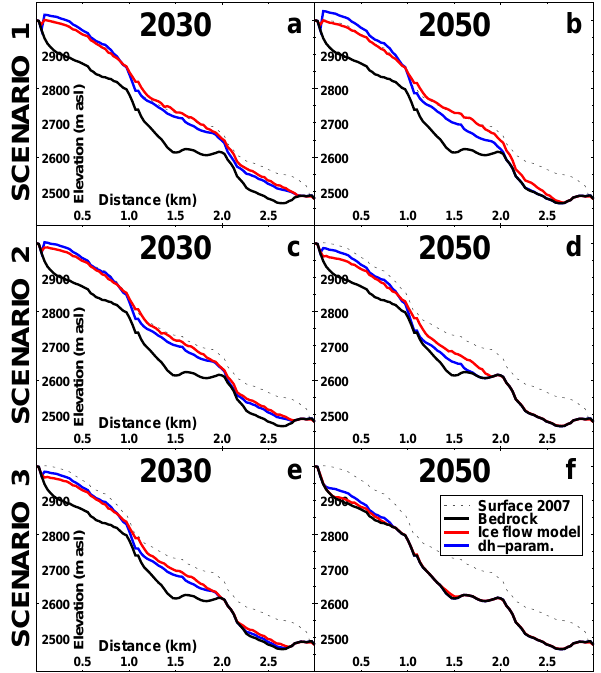
Fig. 8. Evolution of glacier surface elevation along a longitudinal profile calculated for Rhonegletscher using the 3D ice flow model and the ∆ h -parameterization. Results for different climate change scenarios are shown.